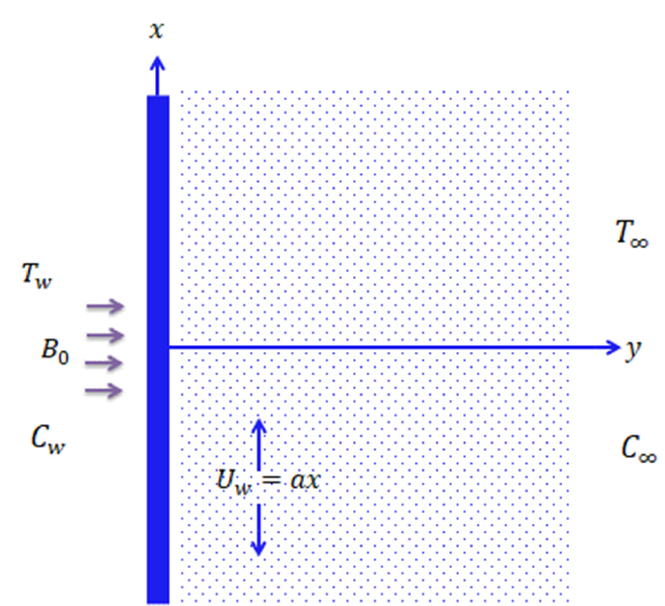
Figure 1. Flow configuration model.